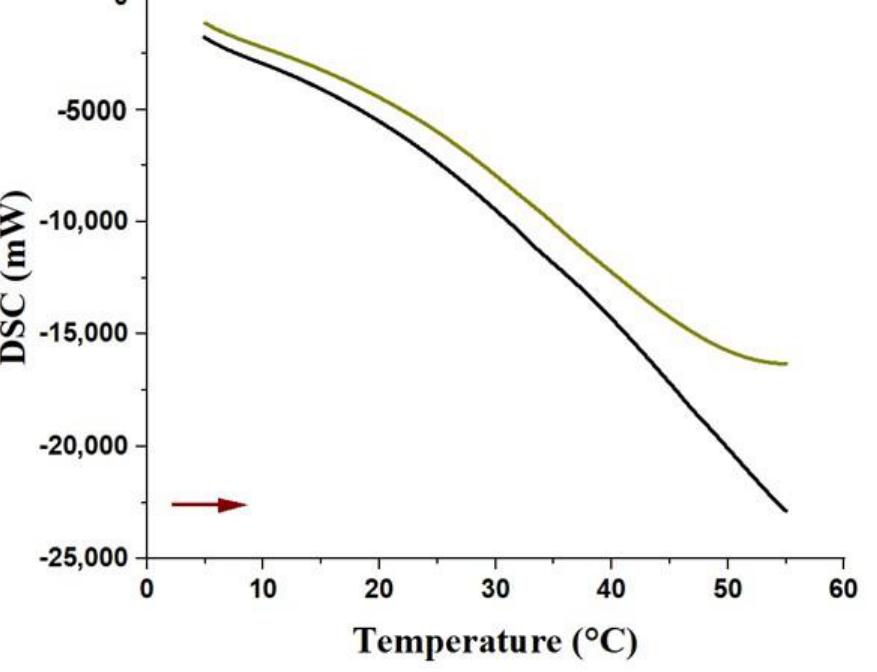
Figure 3. Thermogram of samples analyzed by DSC. Heat flux graph: heating versus temperature (0 – 60 °C; red arrow) of the hydrogel without VADE (black curve) and VADE-loaded-hydrogel (green curve).